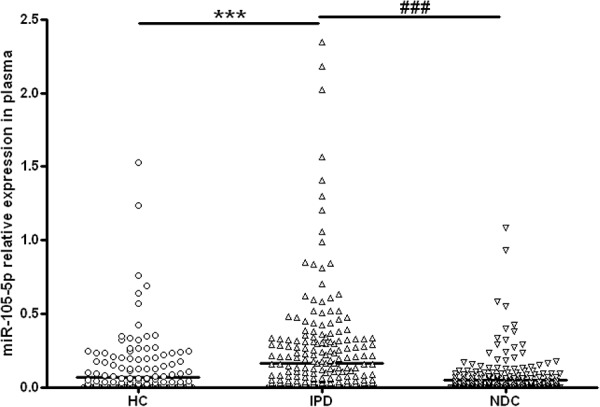
Scatter plots of miR-105-5p relative expression in plasma in different study groups. The level of miR-105-5p expression was significantly increased in patients with IPD (n = 319) as compared with healthy controls (HC, n = 273) and neurological disease controls (NDC, n = 305). Horizontal bars represent median value. Non-parametric ANOVA test, ∗∗∗P< 0.001 vs. HC, ###P< 0.001 vs. NDC.